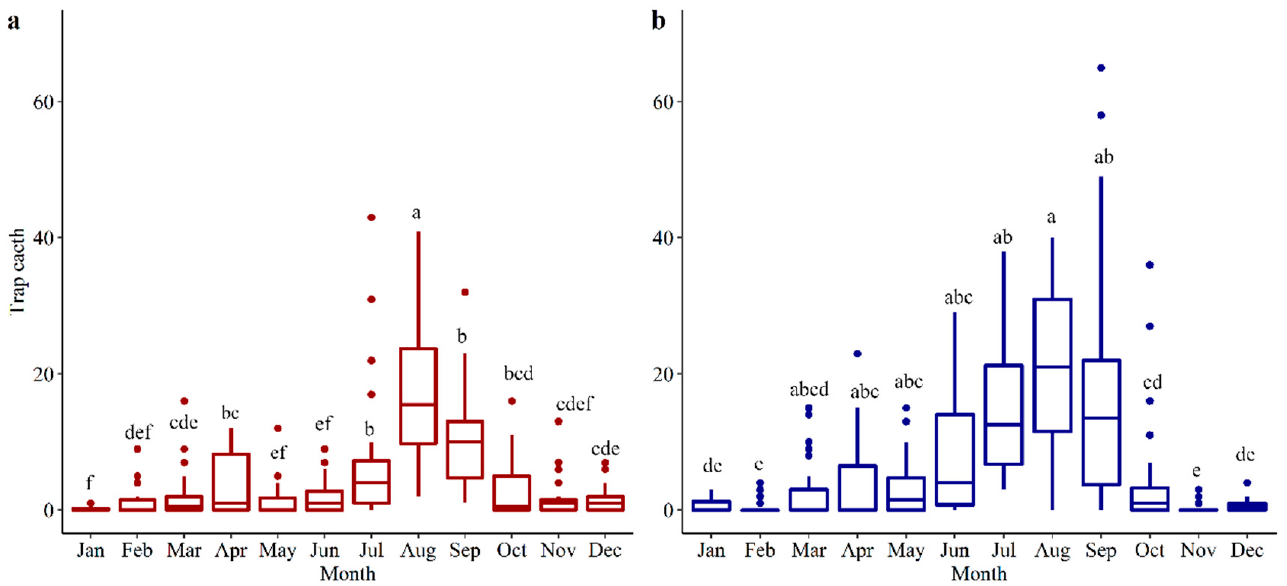
Figure 1. Number of H. zea moths trapped per month ( a ) Jackson and ( b ) Santa Rosa/Escambia counties. Boxplots with the same letters are not significantly different from each other ( p > 0.05). Boxplots indicate the range of data dispersion (first and third quartiles and extreme values), median (solid horizontal line), and outliers (dots falling outside lines). Table 1. Wald χ 2 type III analysis of variance for crop and irrigation system on the H. zea moth catch in Jackson and Santa Rosa/Escambia, Florida, from June 2017 to June